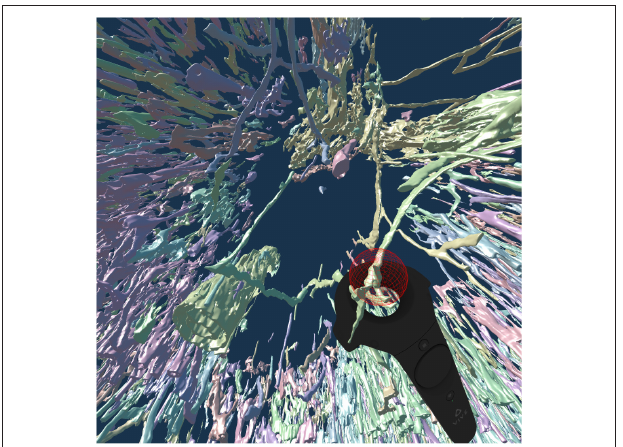
FIGURE 8 | A VR screenshot showing mesh reconstructions of blood vessels in a human spleen specimen, anti-CD34 staining, “follicle-single” data set ( Steiniger et al., 2018a). Unconnected mesh components were set to distinct colors. The user is highlighting a smaller blood vessel that follows larger ones with the HTC Vive controller.